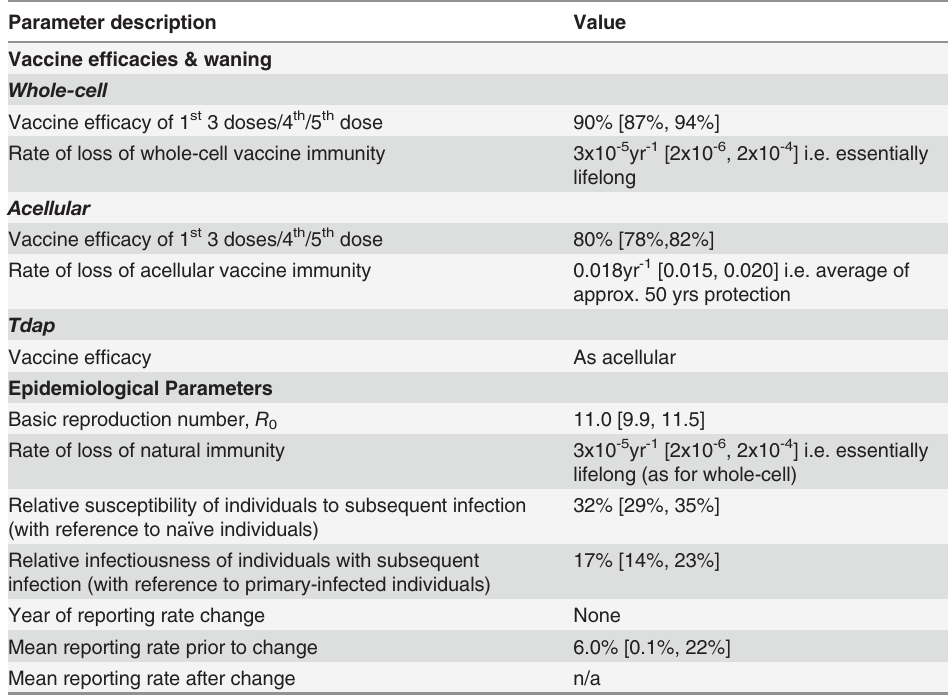
Table 2. Parameter estimates for the best-fitting model, Model 8 (models outlined in Table